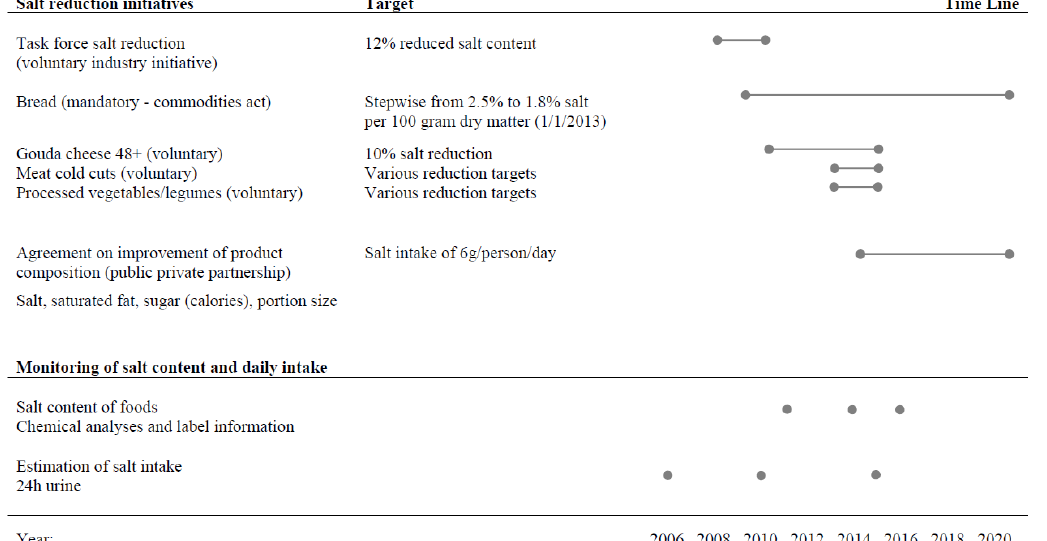
Figure 1. Overview of salt reduction targets and monitoring.